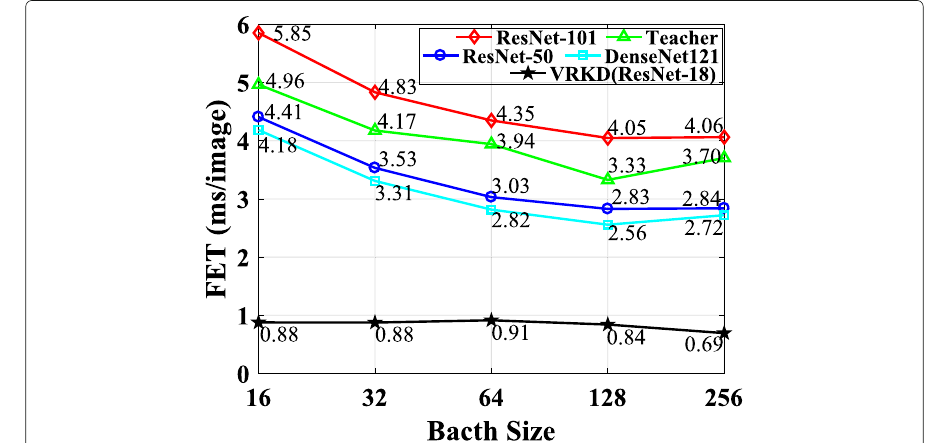
Fig. 5 The feature extraction time (FET) per image